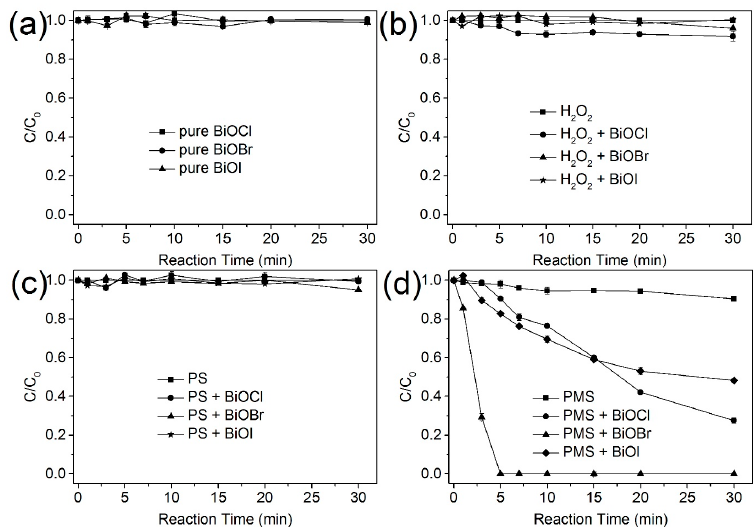
Figure 1. The catalyzed PMS oxidation of CBZ by ( a ) BiOX, ( b ) H 2 O 2 , ( c ) PS and ( d ) PMS. The initial concentration of CBZ ([CBZ] 0 ) = 5.0 µ M, [H 2 O 2 ] 0 = [PS] 0 = [PMS] 0 = 4.0 mM, [BiOX] 0 = 1.0 g/L, pH = 7.0, T = 24 ◦ C. Table 1. Physicochemical properties of H 2 O 2 , PS and PMS. Chemical Structure